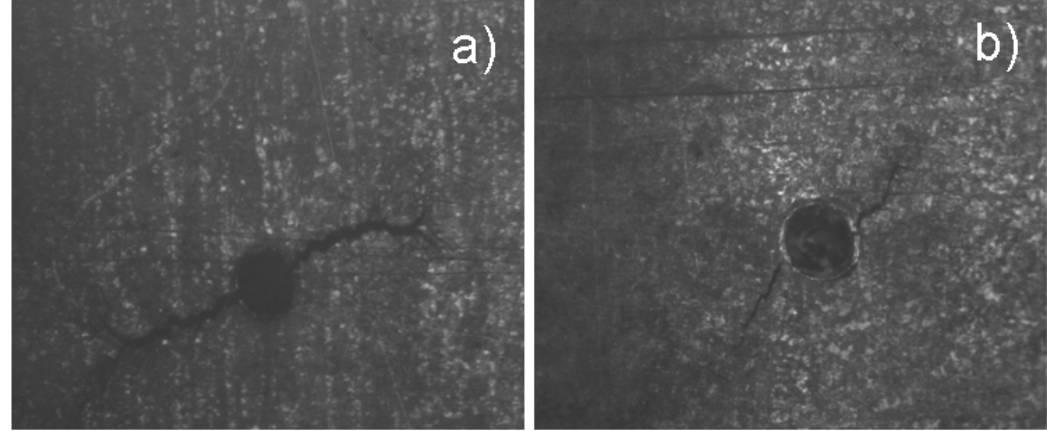
Figure 5: Images acquired for samples a) S2 and b) S4 after 950 and 1300 cycles respectively. The diameter of the hole in both images is 150 μ